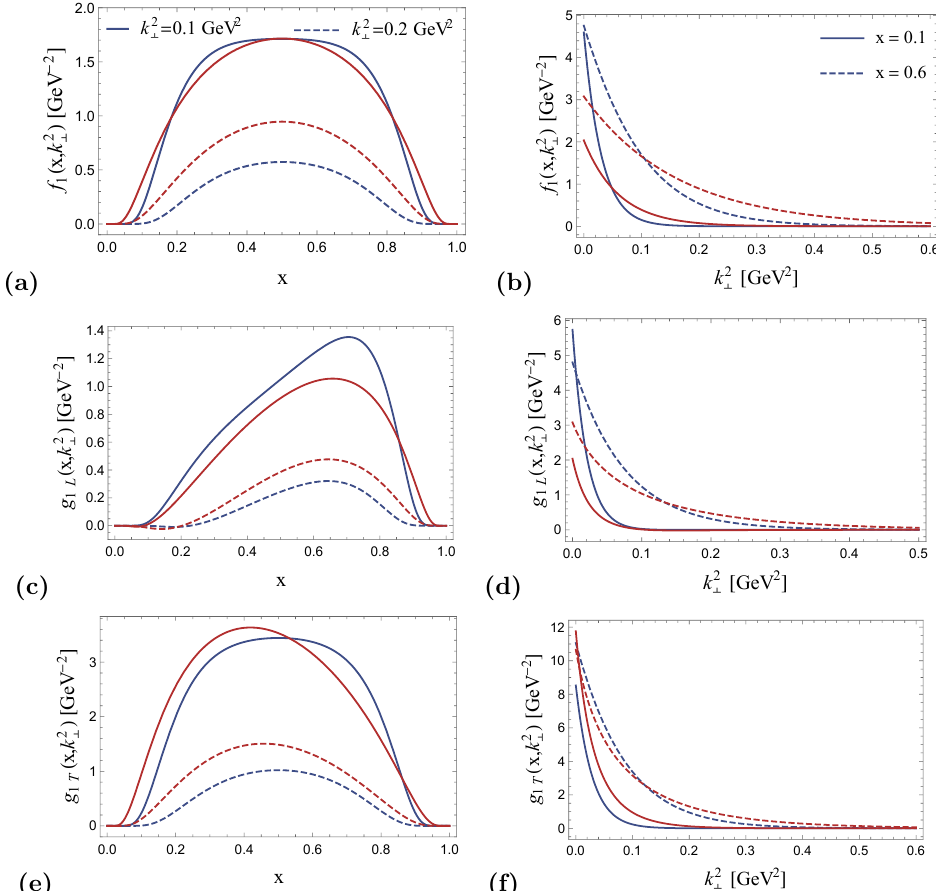
Figure 1 . (Color online) The unpolarized TMD f 1 ( x, k 2 ) and the longitudinally polarized quark ⊥ TMDs g 1 L ( x, k 2 ) and g 1 T ( x, k 2 ) with respect to x at different value of k 2 (left panel), i.e., k 2 = ⊥ ⊥ ⊥ ⊥ 0 . 1 GeV 2 (solid curves) and k 2 = 0 . 2 GeV 2 (dashed curves). On the right panel, these TMDs ⊥ are shown with respect to k 2 at different values of x , i.e., x = 0 . 3 (solid curves) and x = 0 . 6 ⊥ (dashed curves). The blue and red curves correspond to the light-front holographic model at the model scale µ 2 = 0 . 20 GeV 2 and the light-front quark model predictions at the model scale LFH µ 2 = 0 . 19 GeV 2 , LFQM